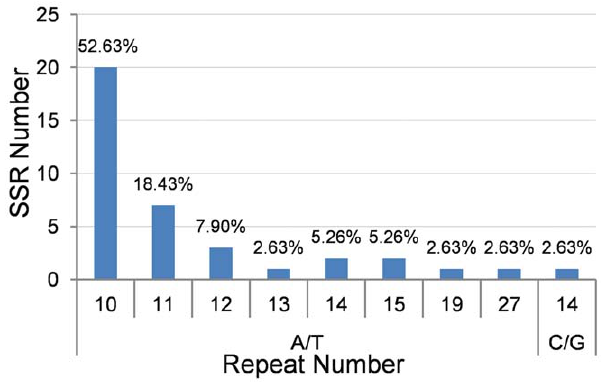
Figure 6. The distribution and frequency of simple sequence repeats in the Artemisia frigida cp genome. The SSR length is implied by the number of repeat for each SSR type in the Y-axes The percentage of a repeat with specific length from the total number of repeats is indicated above the